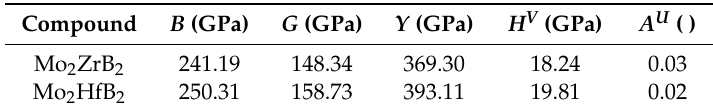
Table 2. Isotropic bulk modulus B , shear modulus G , Young’s modulus Y , Vickers hardness H V and the Universal Elastic Anisotropy Index A U of Mo 2 ZrB 2 and Mo 2 HfB 2.